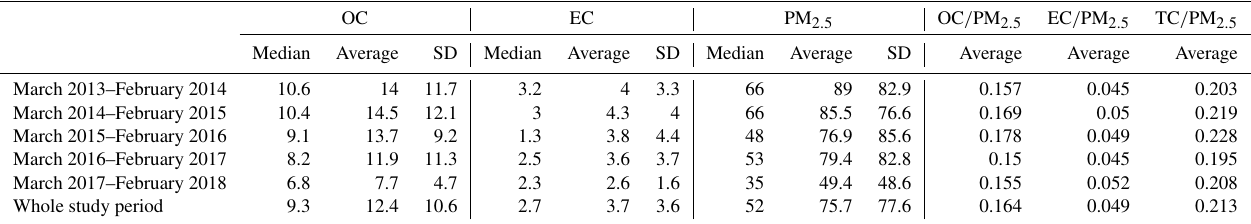
Table 1. Medians, averages, and associated standard deviations for the OC, EC, and PM 2 . 5 concentrations (in micrograms per cubic metre) and averages for the OC / PM 2 . 5 , EC / PM 2 . 5 , and TC / PM 2 . 5 ratios from March 2013 to February 2018. OC EC